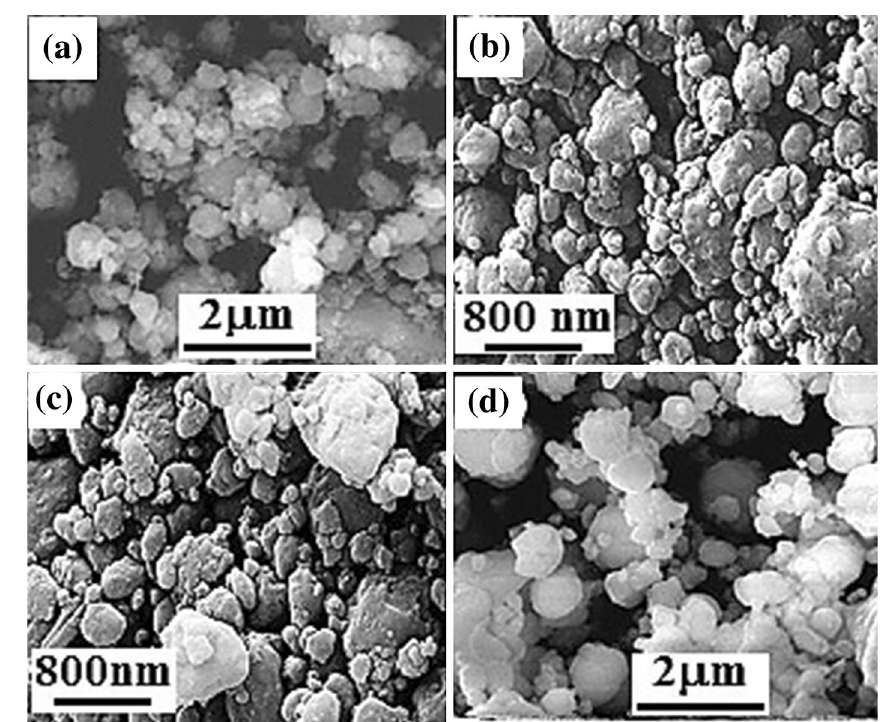
Fig. 8 The SEM images of MgH 2 -6 wt% of mischmetal ball-milled for a 10, b 20, c 30, and d 40